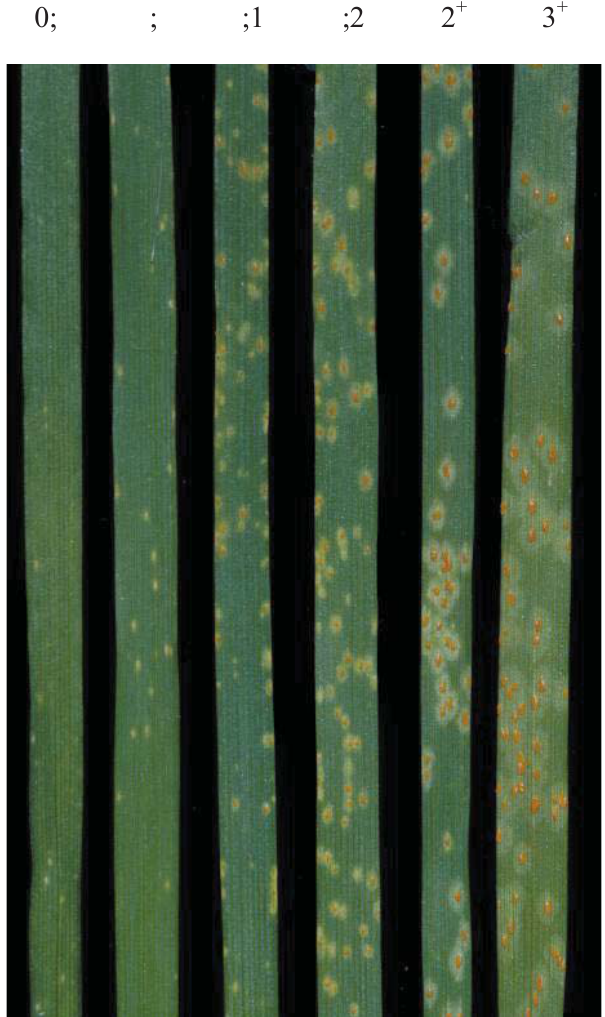
Figure 3. Infection types of a single Puccinia triticina race on Thatcher backcross lines of wheat with single leaf rust resistance genes. Infection type 0; to 2 + are considered